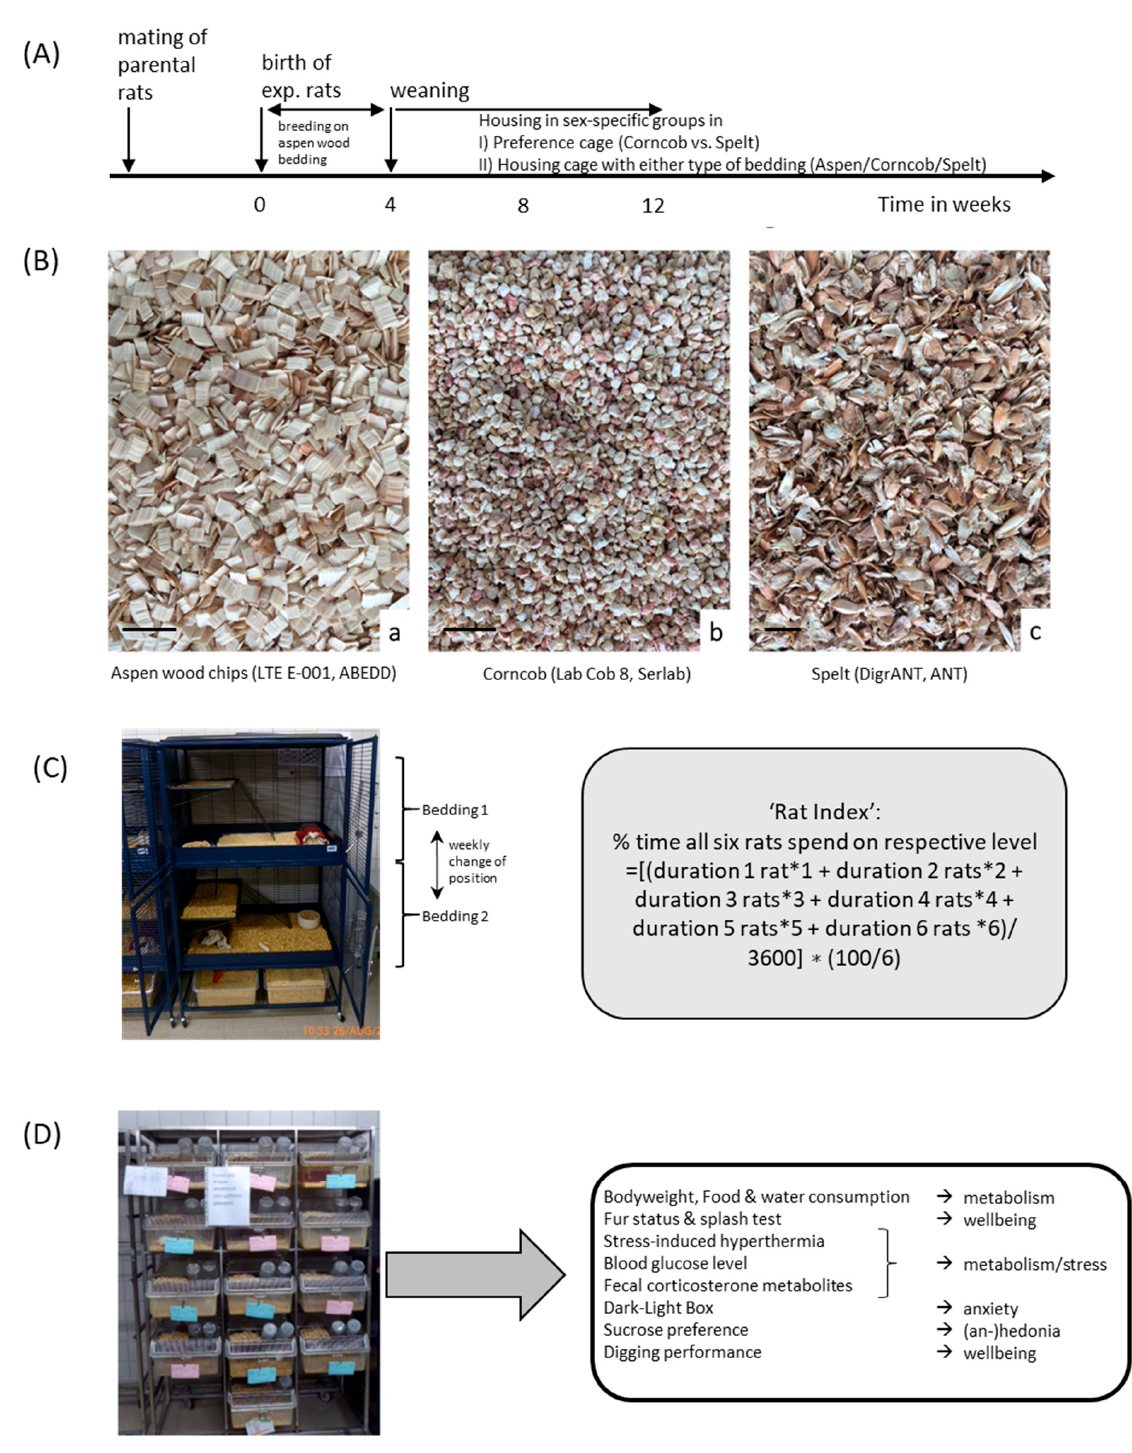
Figure 1. Timeline, bedding material, and experimental set-up. ( A ) For the experiments, after weaning at postnatal Day (PND) 28, the rats were transferred from aspen wood chip bedding to either the preference test setup or type IV cages containing corncob, spelt, or aspen wood chips (control condition); ( B ) illustration of consistency of aspen wood chips, corncob, and spelt bedding substrate, the scale bar represents 1 cm; ( C ) preference test setup to assess ‘rat index’ (RI). Preference cages contained four floors with two different types of bedding, i.e., corncob and spelt, which was changed weekly. The floors were accessible via ladders. Upper and lower cage segments were additionally equipped with red plastic huts and nesting material. Food and water were available ad libitum in upper and lower floors. The ‘rat index’ represents the percentage of time rats spend time on the upper level, and it was calculated by the depicted formula; ( D ) Macrolon ® type IV cages were filled with corncob, spelt, and aspen wood chips to analyze the effects on behavior and stress